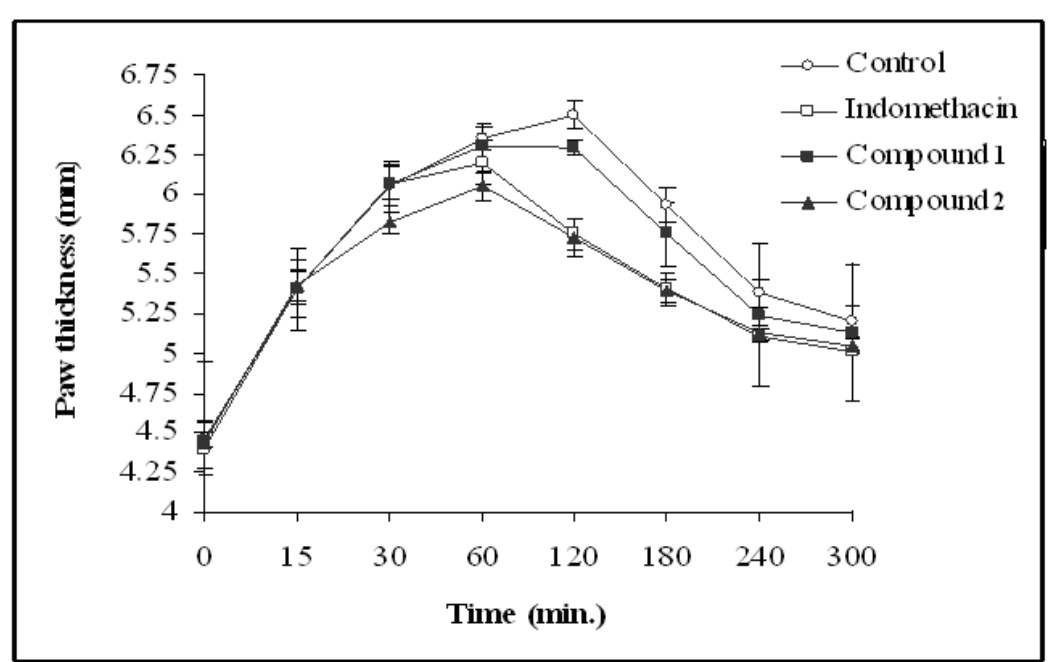
Fig. (1): Paw thickness of rats treated with indomethacin, compound 1 and compound 2 with respect to control. Results are expressed as means ± SEM (n=6).